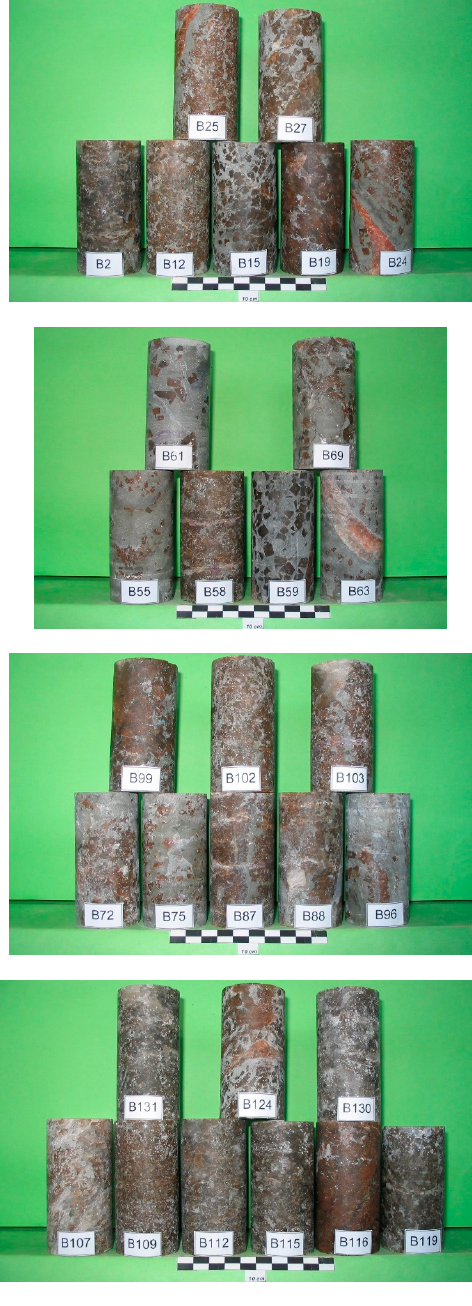
Figure A1. The Brown Zuber unit samples for short-term compression tests at a constant stress rate and for rheological tests.